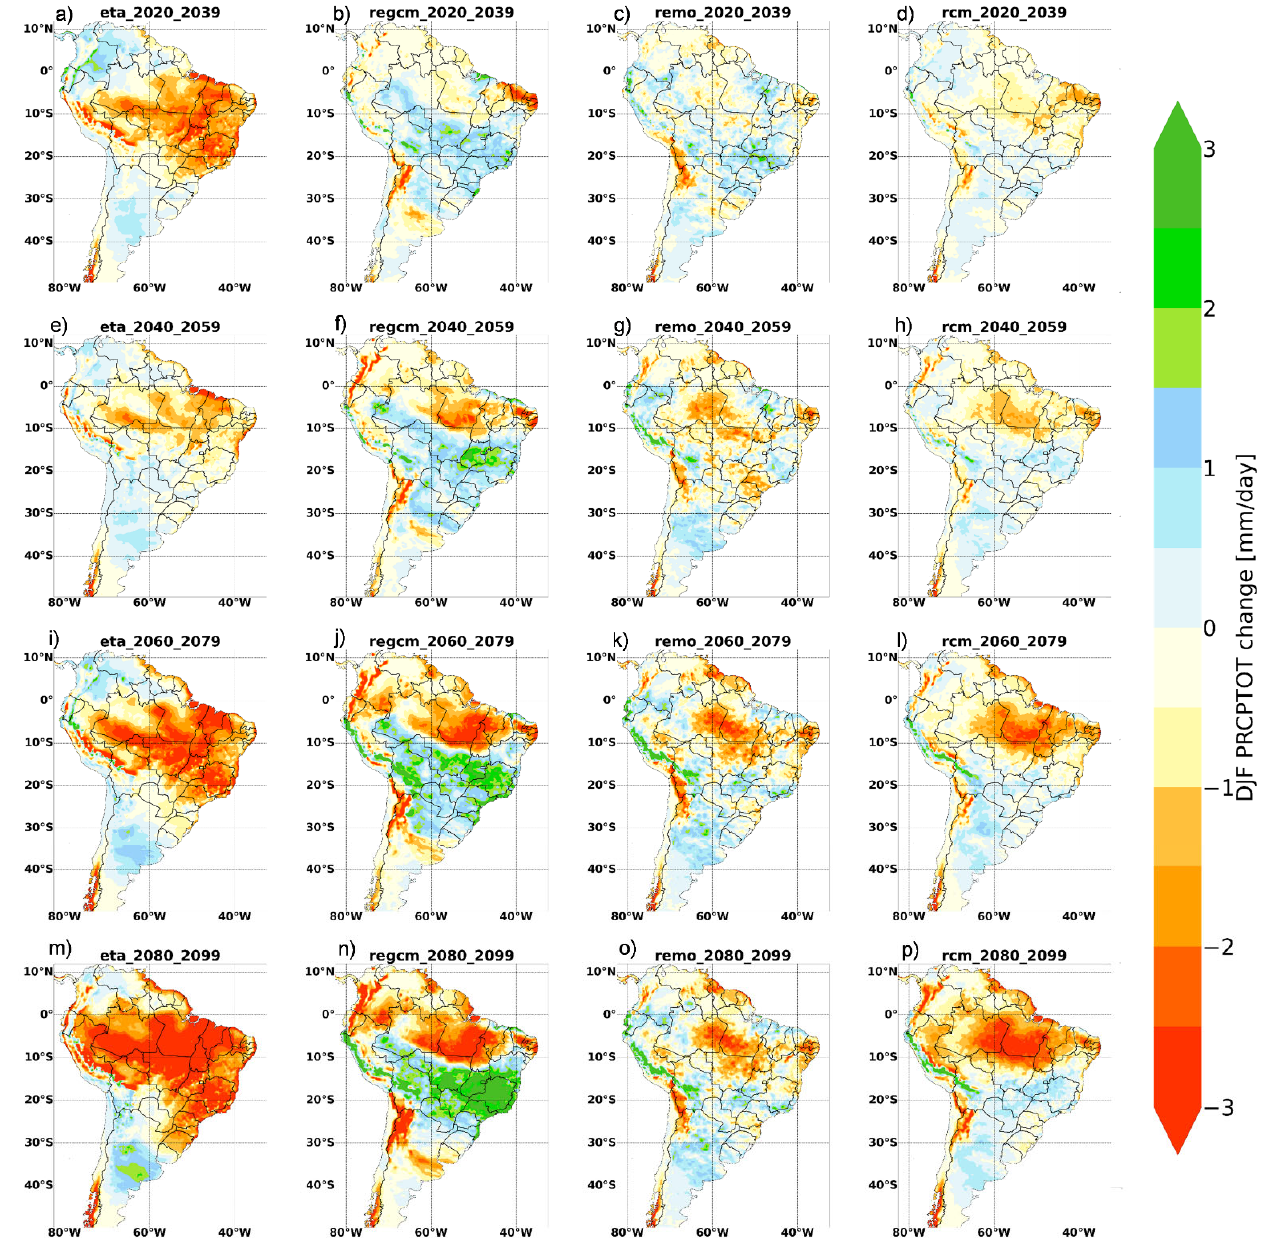
Figure 4. Changes projected to PRCPTOT (mm/day) during austral summer computed from each RCM ensemble (Eta, RegCM, and REMO) and 3RCMs ensemble (right column) and considering four time ‐ slices: ( a – d ) 2020–2039, ( e – h ) 2040–2059, ( i – l ) 2060–2079, and ( m – p ) 2080–2099.